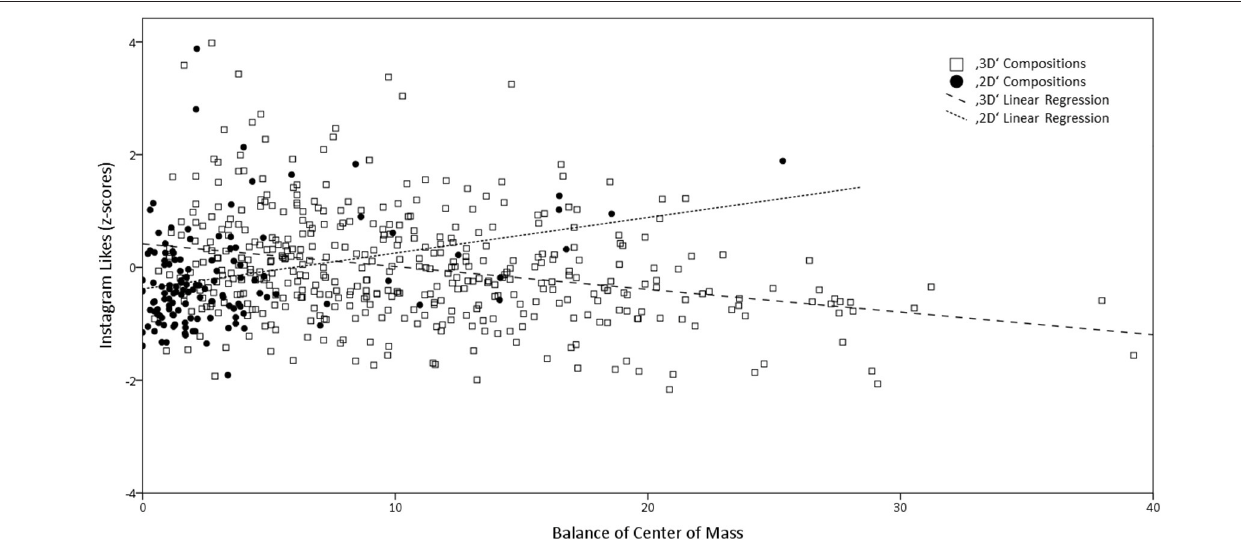
FIGURE 7 | This figure illustrates the difference between “2D” vs. “3D” photographs in visual balance effects on Instagram Likes, using the example of the BAL DCM measure. Depicted are “2D” compositions by Alex Hamburg ( n P -values for Pearson correlations * p < 0.05, ** p <